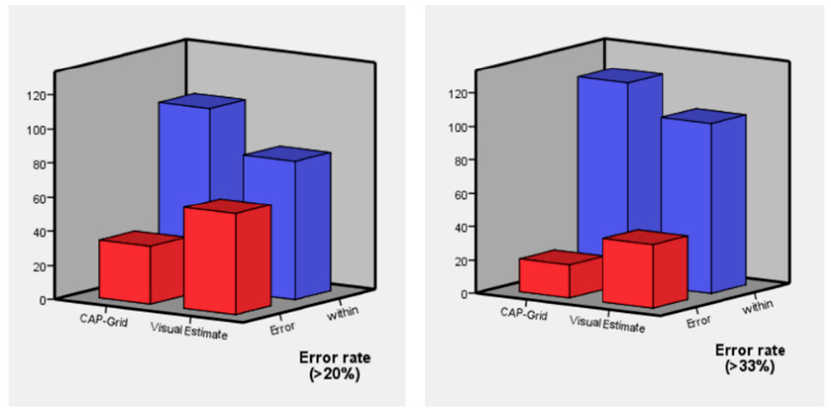
Figure 4. Discrepancy percentages in both groups.